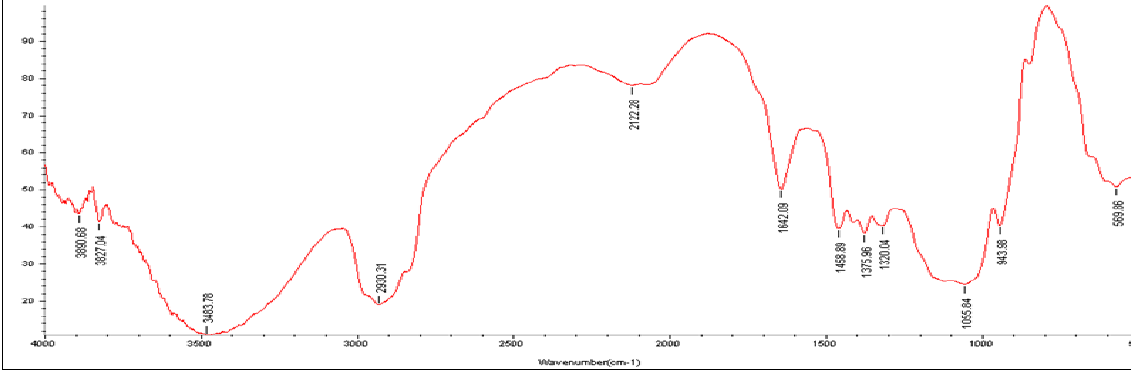
Figure (11) FTIR spectrum of pure HPMC E5 powder